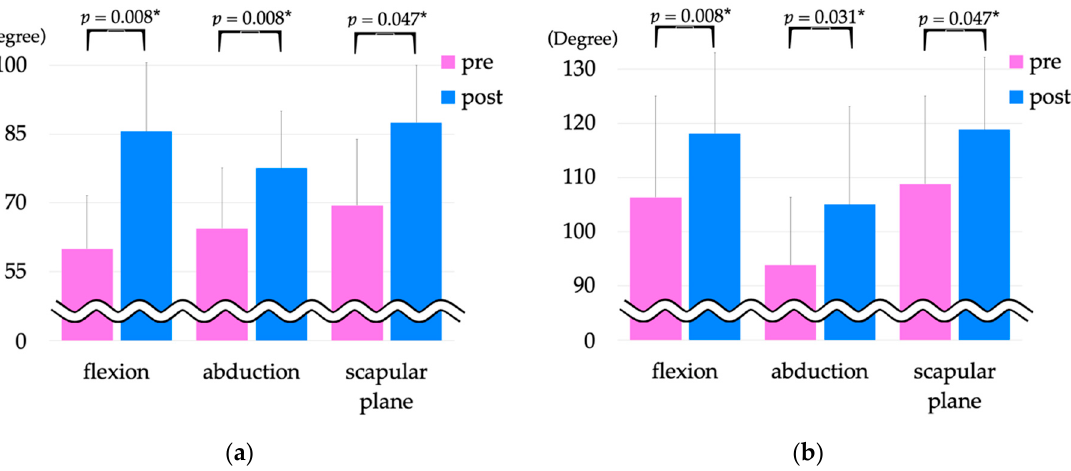
Figure 3. Shoulder joint ROM pre ‐ and post ‐ intervention. ( a ) Voluntary shoulder joint range of mo ‐ tion pre ‐ and post ‐ intervention, ( b ) passive shoulder joint ROM pre ‐ and post ‐ intervention. * Indi ‐ cates p < 0.05. ROM, range of motion.